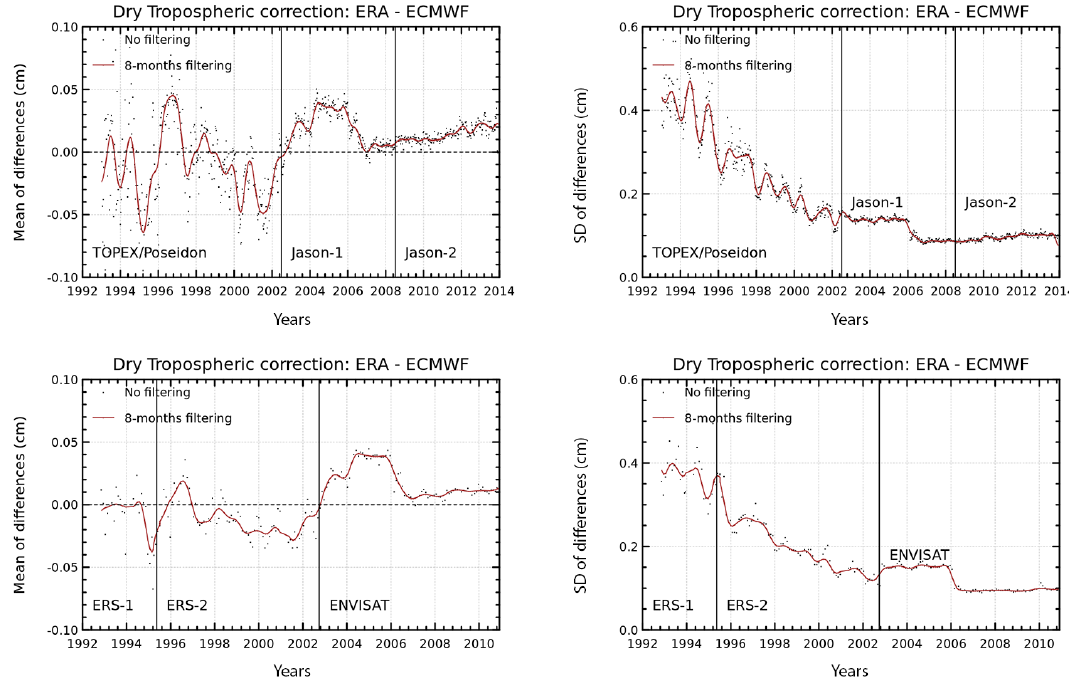
Figure 5. Temporal evolution of the differences between dry tropospheric ERA and the operational dry tropospheric correction seen by each altimeter missions series: TP, J1, J2 time series (top), and ERS-1, ERS-2, and Envisat time series (bottom) (mean and standard deviation in